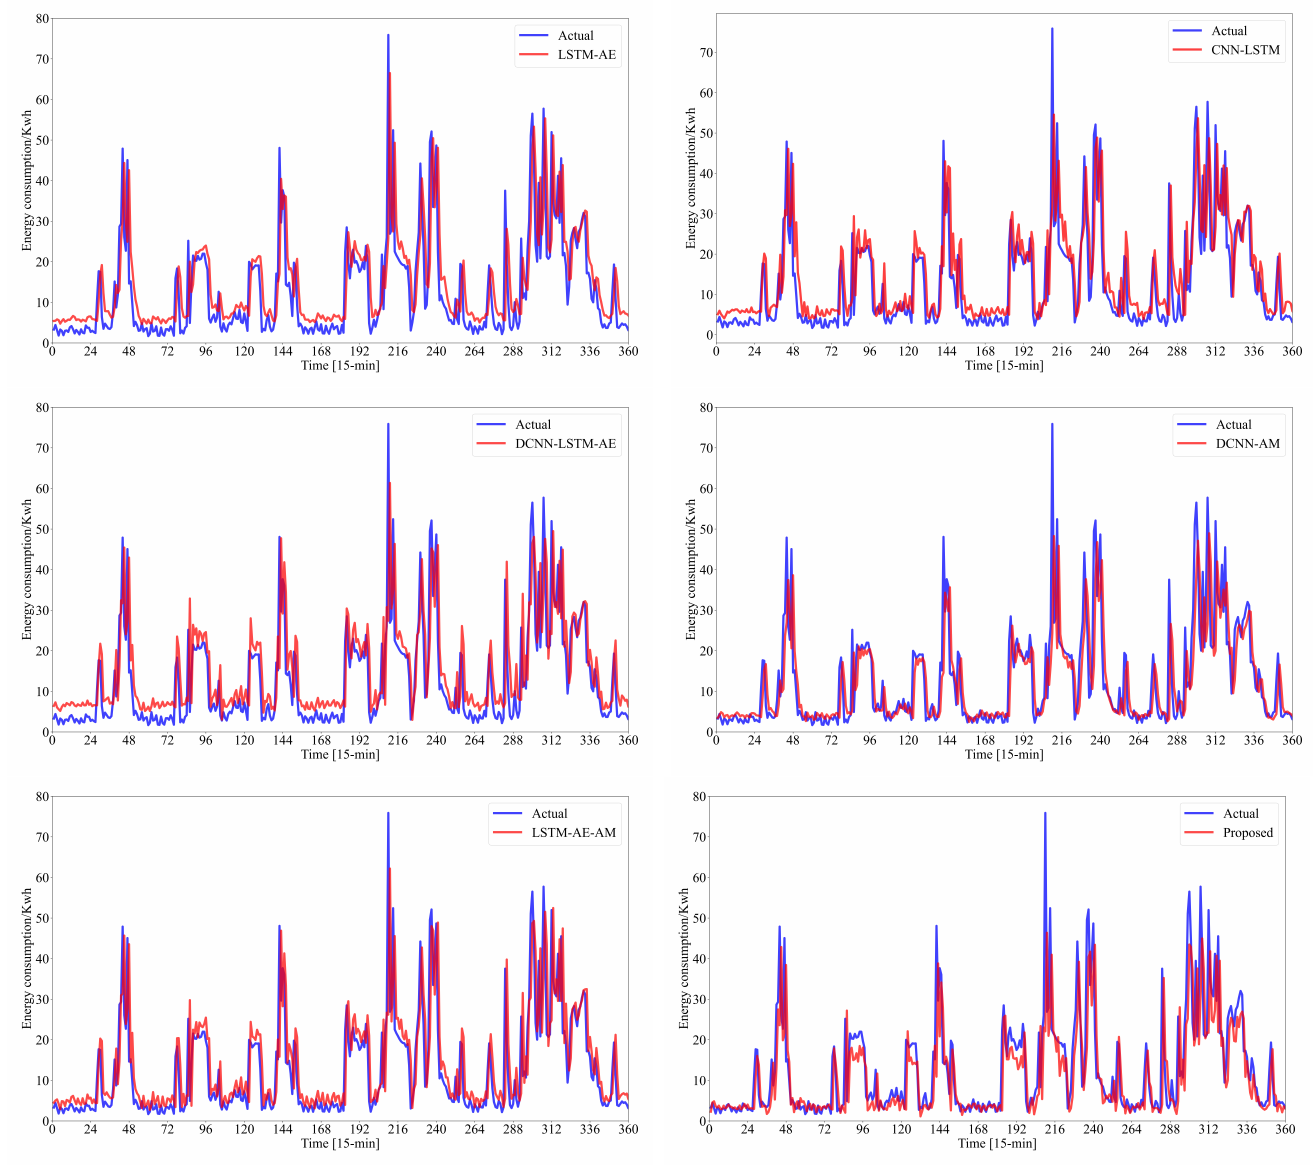
Figure 12. Prediction results of some hybrid models on the IHEPC dataset at a 15-min